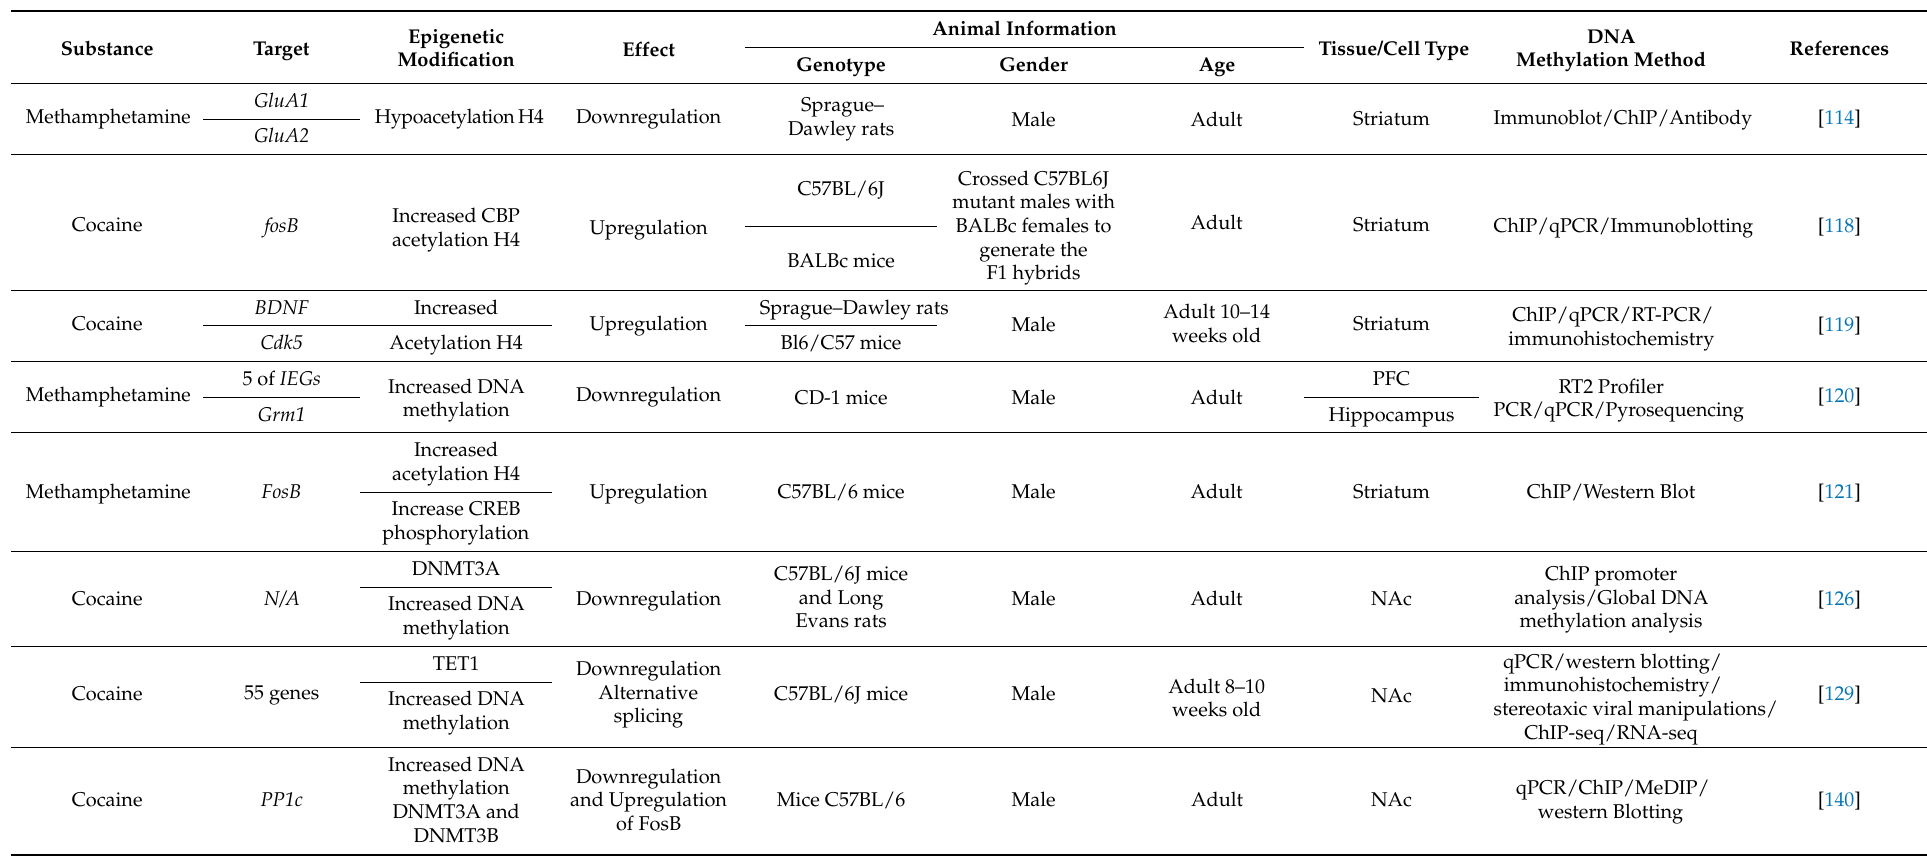
Table 2. Summary of information obtained from the available literature about the main epigenetic changes observed in rodents after intake of traditional stimulants. We report: the substances, the effects found after epigenetic modification, information on the animal model used (by specifying genotype, gender and age), and which detection method is the most appropriate to identify the previously highlighted epigenetic